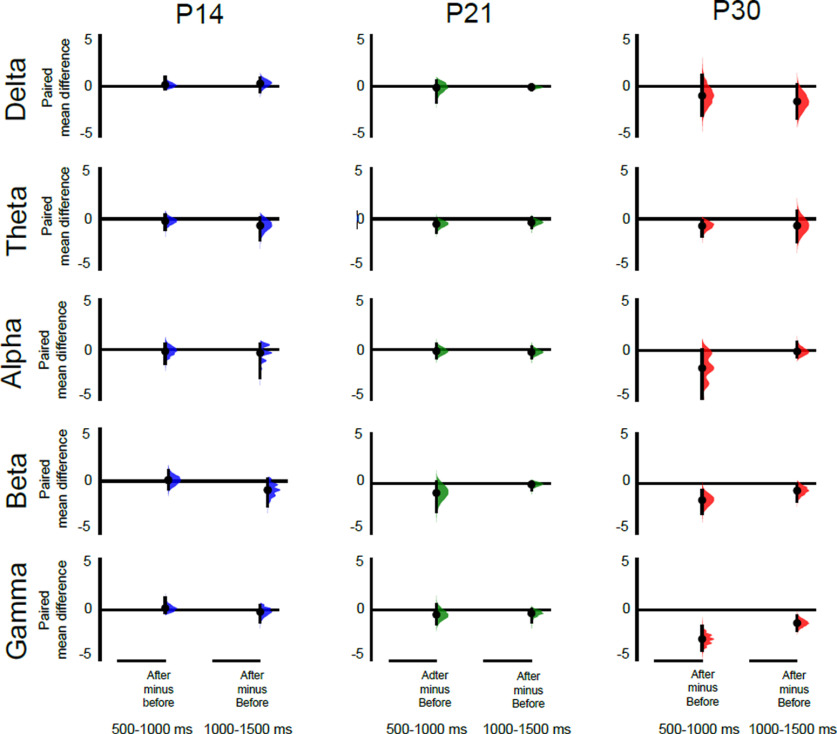
Silencing cutaneous C fibers causes distinct age-related decreases in S1 γ and β oscillatory energy. Differences in the energy evoked by stimulation after QX-314 treatment versus before treatment in P14, P21, and P30 S1 (n = 6 animals per age). The paired mean difference at 500–1000 and 1000–1500 ms poststimulus are shown for each frequency band [δ (2–4 Hz), θ (5–7 Hz), α (8–12 Hz), β (15–29 Hz), and γ (30–90 Hz)]. Mean differences are depicted as dots; 95% confidence intervals are indicated by the ends of the vertical error bars. A negative value indicates a decreased energy following QX treatment compared before treatment and can be attributed to silencing of C fibers. Significant decreases in γ and β energy occur at P30. A decrease in β energy at P21 at 0–500 ms is not shown. See text for effect sizes, confidence intervals and permutation p values. Each paired mean difference is plotted as a bootstrap sampling distribution, using 5000 bootstrap samples, and the confidence intervals were bias corrected and accelerated (Ho et al., 2019).